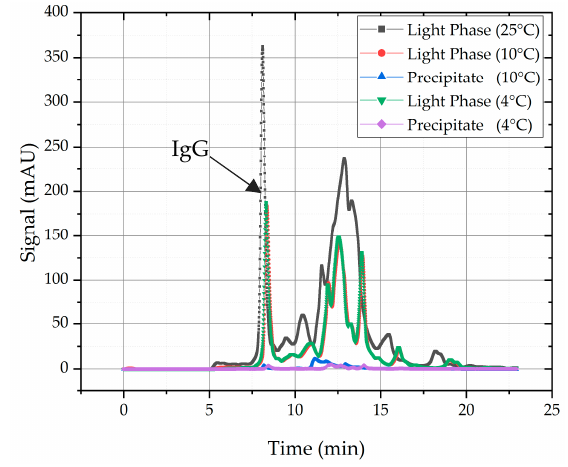
Figure 5. Comparison of proteins in light phase at 25 °C, 10 °C, and 4 °C. Precipitation occurs at 10 °C and 4 °C. Dissolution was conducted with a PBS buffer at pH = 7.4.